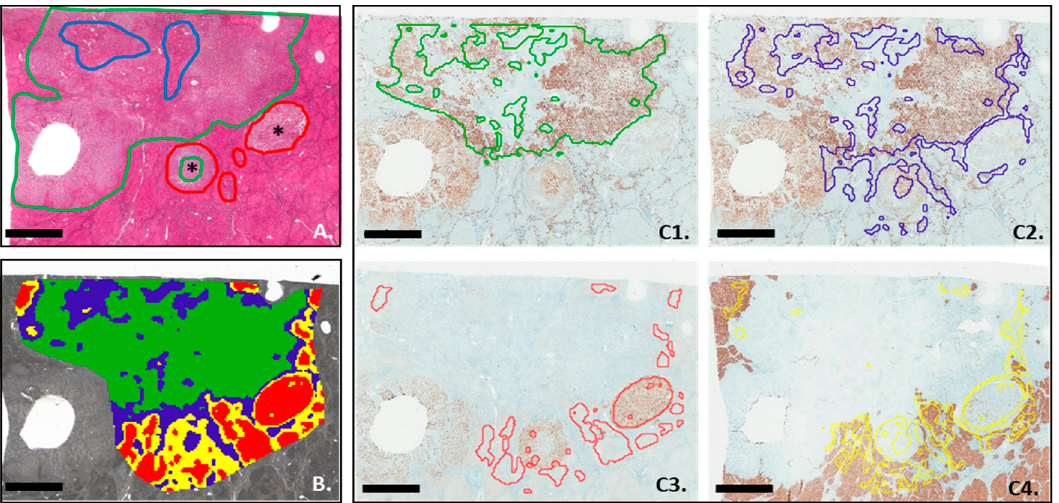
Figure 4. Segmentation analysis overlaid with immunohistochemistry performed on successive slices from Patient 2. ( A ) Pathological annotations with colors that indicated areas of cholangiocarcinoma (green), areas of hepatocarcinoma (red), fibrosis derived from cholangiocarcinoma (blue), and fibrosis from a tumor capsule (yellow). Asterisks: MVI. ( B ) The segmentation analysis was set to four clusters: blue: cholangiocarcinoma-related fibrosis; red: HCC; green: iCCA; and yellow: fibrosis around cirrhotic nodules. ( C1 , C2 ) = CK7 staining; ( C3 ) = glypican staining; ( C4 ) = HepPar-1 staining. Scale bar = 3 mm .